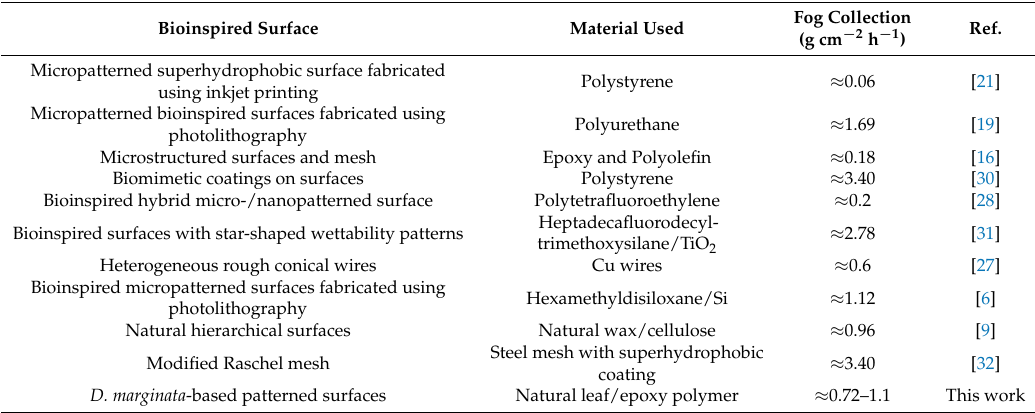
Table 2. Comparison of fog-collection performance of different bioinspired surfaces reported in the